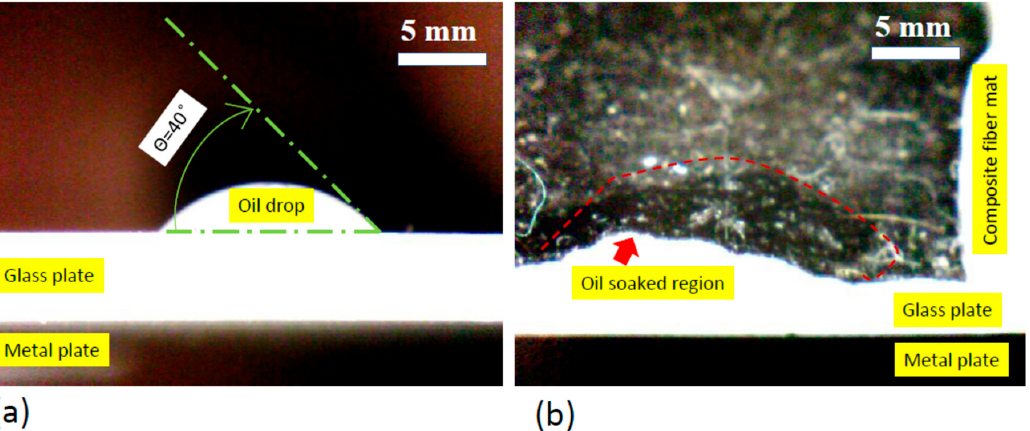
Figure 8. Images showing the contact of oil with a glass plate ( a ) and with a composite fiber mat ( b